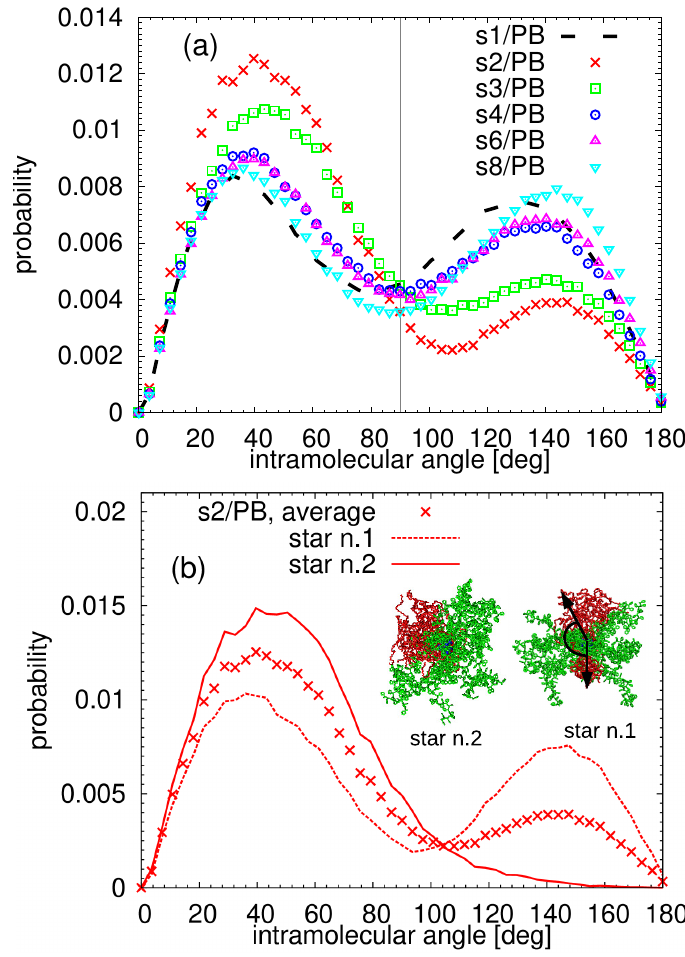
Figure 3. The intramolecular space arrangement of the PEO arms: the distributions of the angles among all inner center-to-end vectors of the PEO arms. Two examples of the center-to-end vectors are illustrated by the black arrows, the angle between them by a black solid line. In ( a ), the distributions are averaged over all the stars in the system, in ( b ), the solid and dashed lines represent the data calculated only for a specific selected star of s2/PB system. A representative snapshot of a selected star is also included. The vertical grey solid line in ( a ) marks the 90 ◦ criterion for the algorithm detecting the patchy